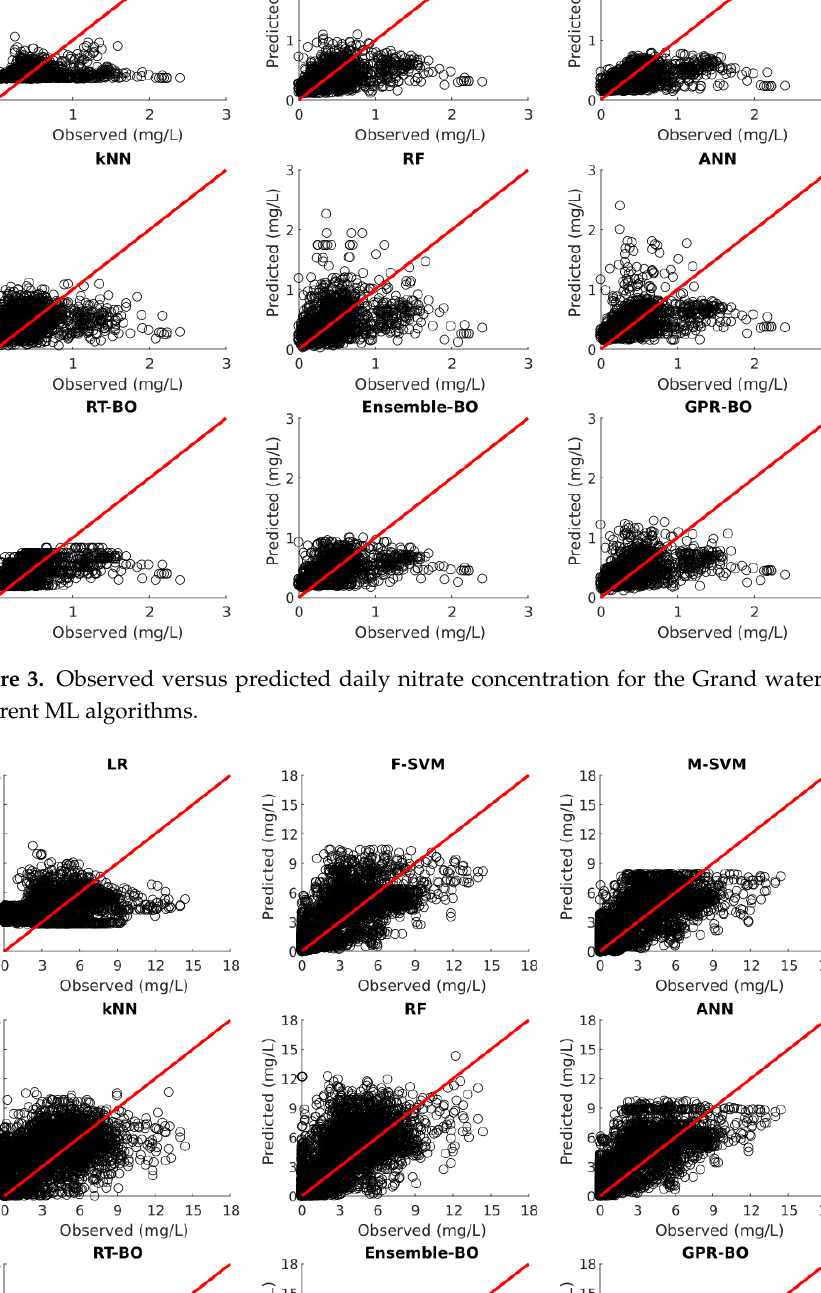
Figure 2. Observed versus predicted daily nitrate concentration for the Cuyahoga watershed using different ML algorithms.